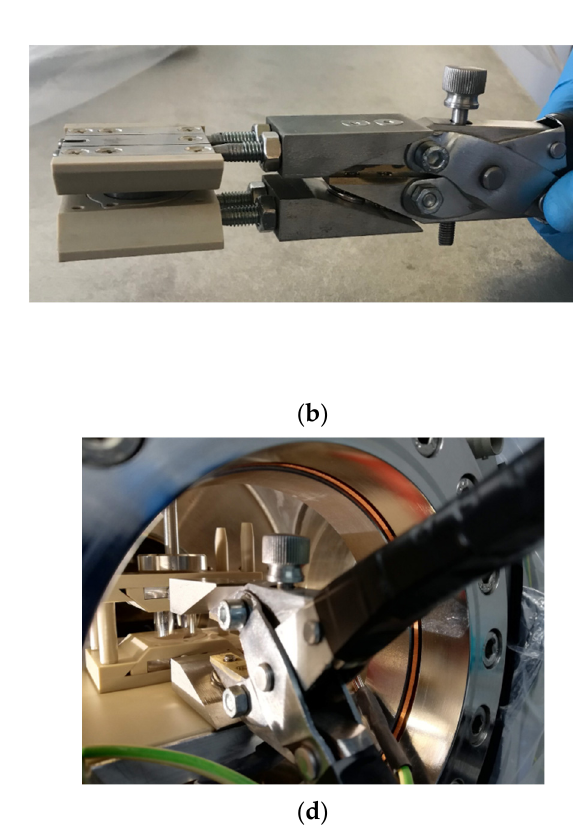
Figure 8. New design of the sample holder: ( a ) loading of the powder in the cylinder; ( b ) top and bottom parts kept together by the parallel clamp before insertion or after extraction; fixation of the top and bottom parts in the gripping structure inside the vacuum chamber, in the case of 1 cm ( c ) and 2 cm ( d ) cylinder from different points of